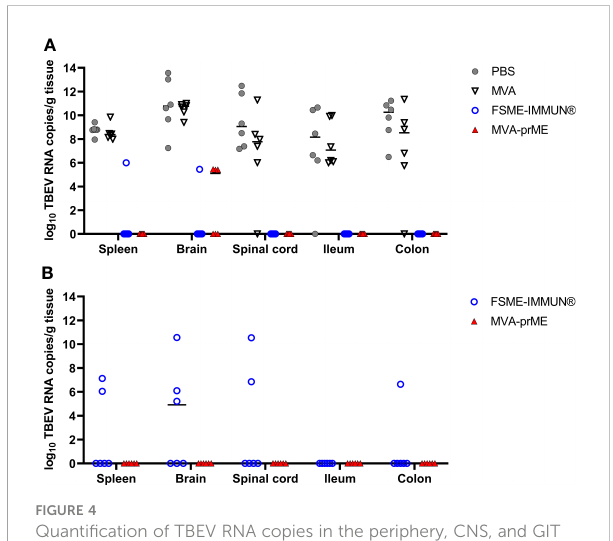
FIGURE 4 Quanti fi cation of TBEV RNA copies in the periphery, CNS, and GIT of vaccinated and infected mice. Cleared organ homogenates collected on the day of sacri fi ce were tested for the presence of TBEV RNA by real-time RT-qPCR. Mice were either sacri fi ced at (A) 8 dpi or (B) stayed in the experiment until the study endpoint (16 dpi). The median values of the respective treatment groups are indicated in the graphs. Mice were immunized with PBS (gray circle), MVA (non- fi lled triangle), FSME-IMMUN ® (non- fi lled blue circle), or MVA-prME (red